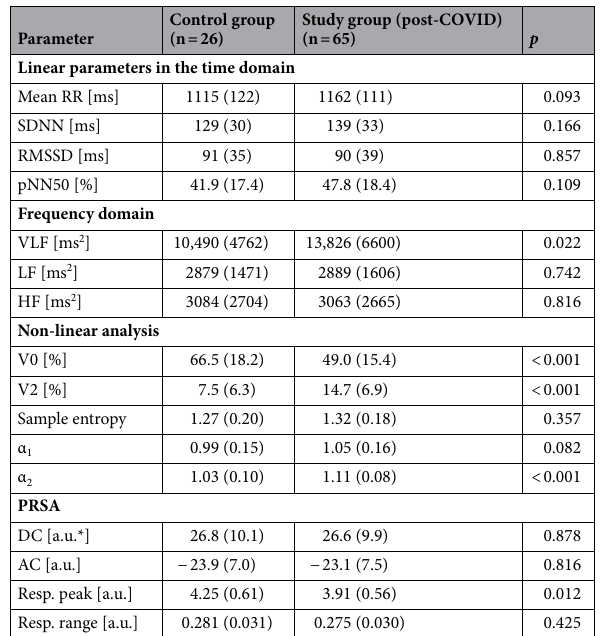
Table 2. Comparison of the mean HRV parameters between the study groups. *a.u.- arbitrary units, see details in the “Methods”